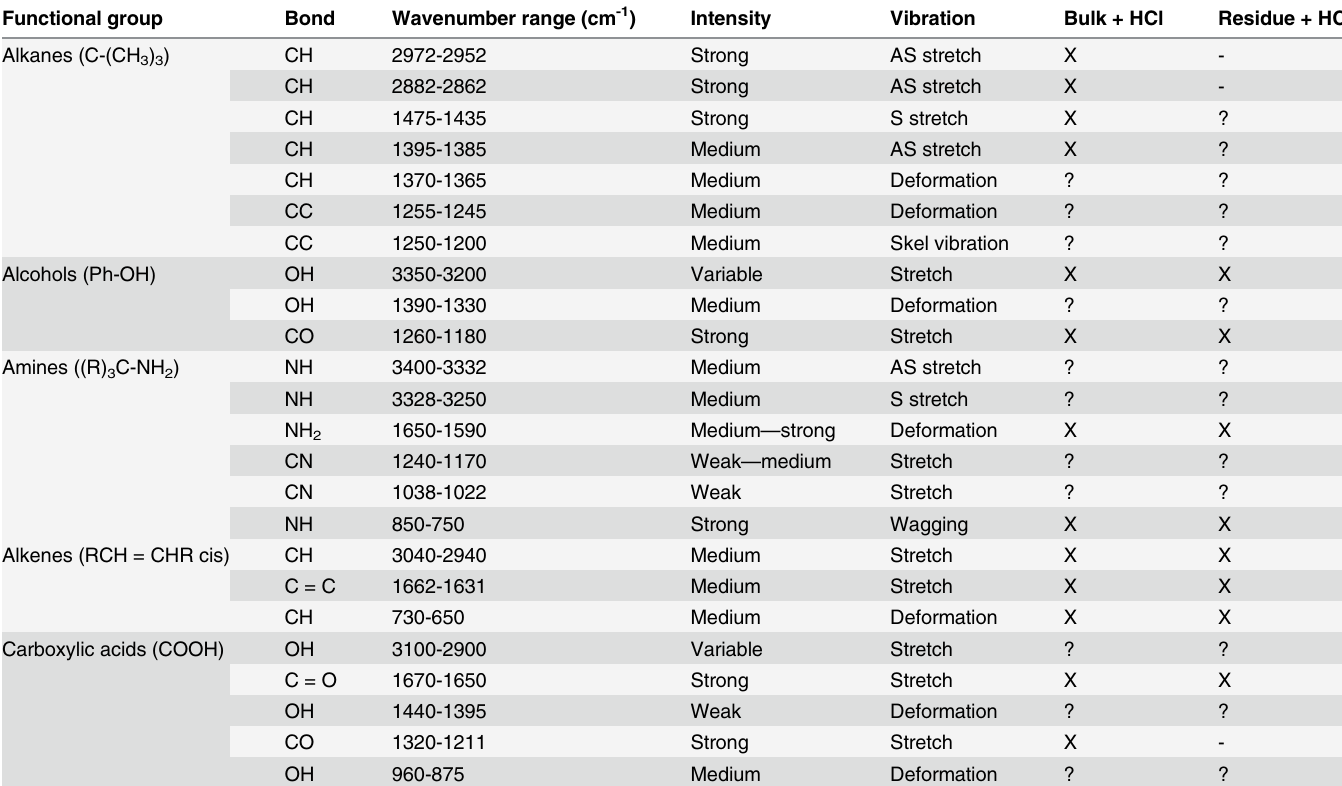
Table 3. Infrared apsorption bands of UOM-232.